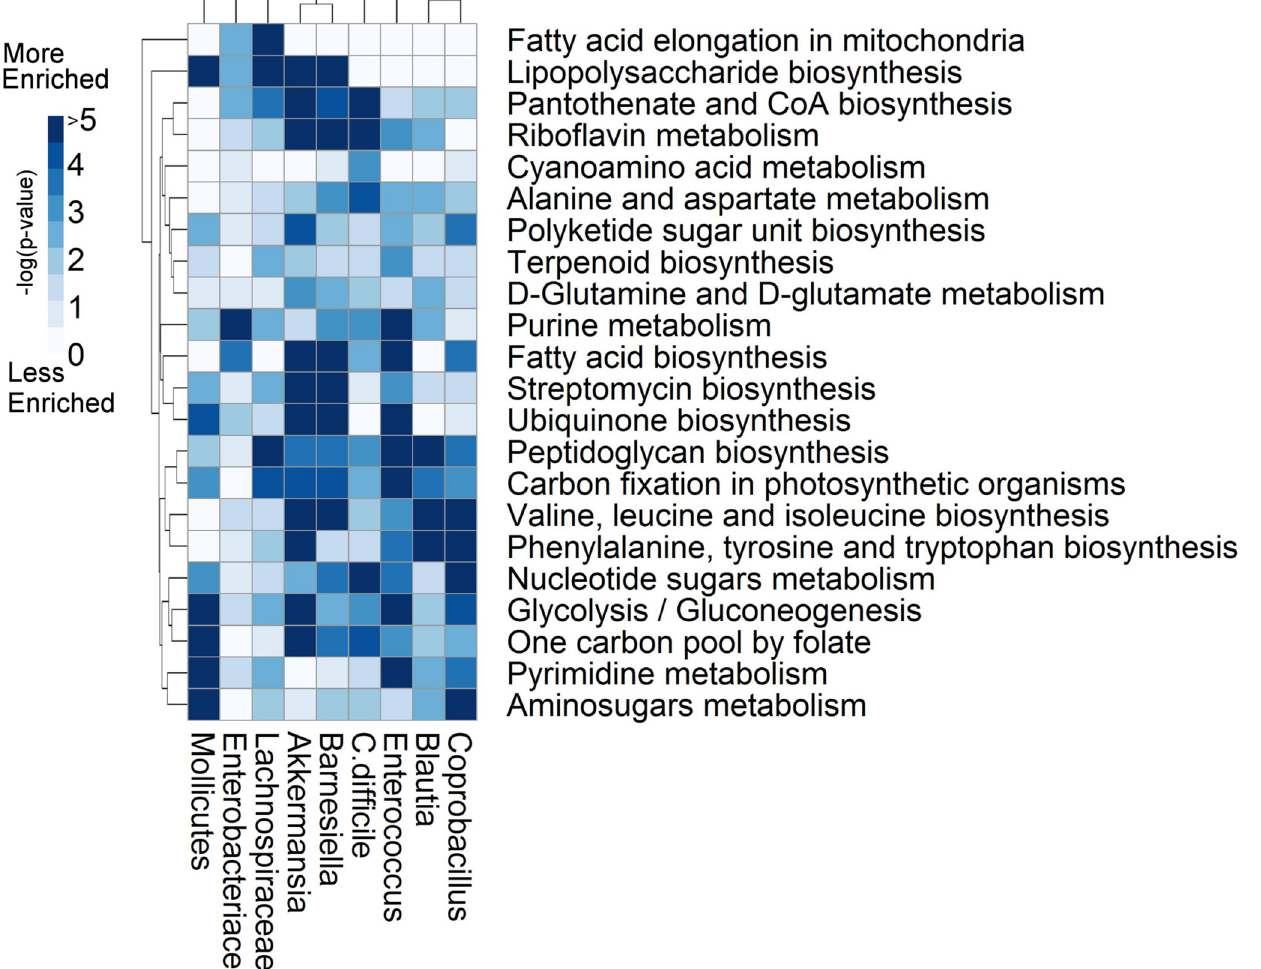
Fig 4. Subsystem enrichment analysis highlights metabolic differences between taxa. The p-values from the enrichment analysis are log-transformed and negated, such that darker regions indicate greater enrichment. The enrichment analysis quantifies the likelihood that a given subsystem (row) would be as highly abundant as observed within a given metabolic reconstruction (column) by chance alone. A subset of 22 interesting subsystems is shown here. Subsystems of interest include those for which all taxa are enriched, such as glycolysis, and nucleotide sugars metabolism, highlighting the fact that all taxa contain relatively full compliments of reactions within those subsystems. Similarly, subsystems for which a single genus differs from the remaining genera are interesting, such as cyanoamino acid metabolism, where C . difficile is highly enriched for reactions in that subsystem. Some subsystems are differentially enriched between Barnesiella and Lachnospiraceae , and C . difficile such as lipopolysaccharide biosynthesis and cyanoamino acid